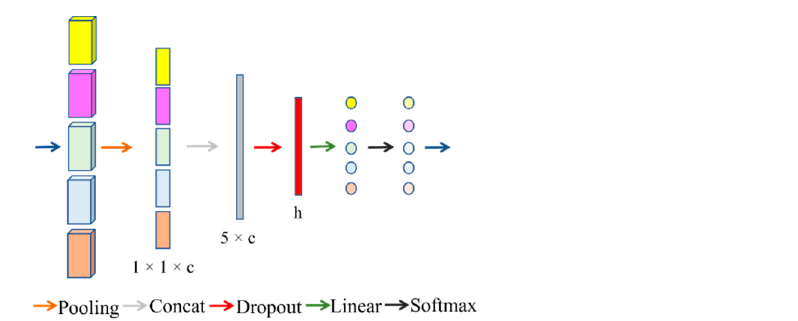
Figure 5. Attention structure. The color of the input block corresponds to the different dimensions of Figure 1; after linearization, the different colors represent different attention scores.